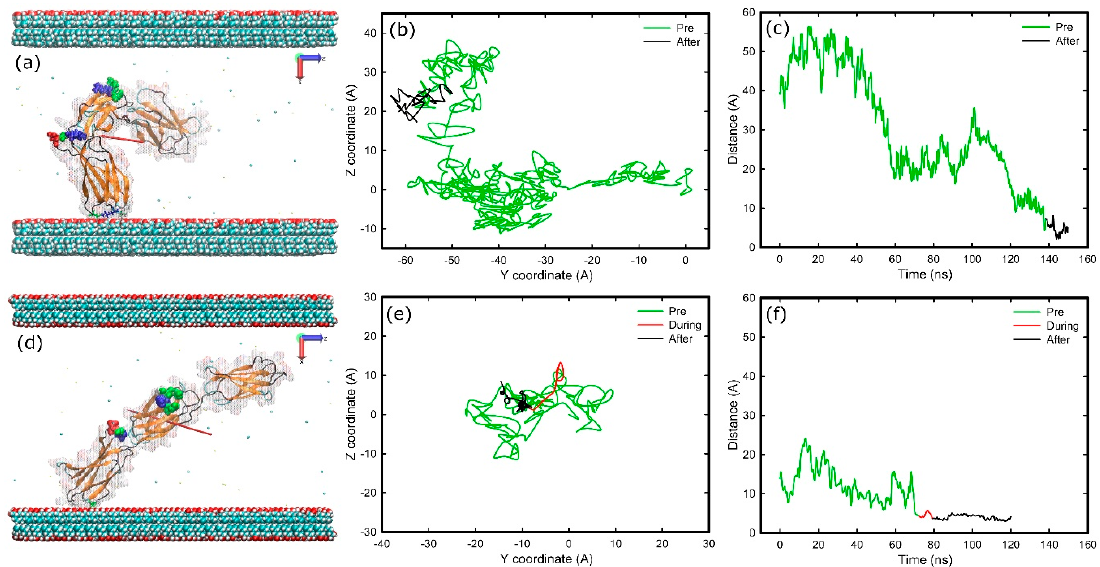
Figure 7. Adsorption of FNIII 8–10 on hydroxyl surfaces on two different systems; ( a – c ) methyl-hydroxyl, ( d – f ) hydroxyl-hydroxyl. ( a , d ) Snapshots at the end of simulation, ( b , e ) diffusion of the anchoring residues over the surface, ( c , f ) distance of the anchoring residues perpendicular to the surfaces over time. The colour-coding is the same as Figure 1.